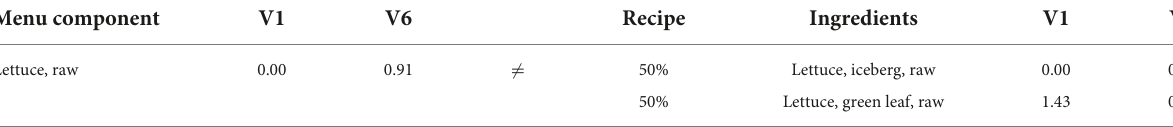
TABLE 1 Example of a discrepancy in food databases with implications for comparison.